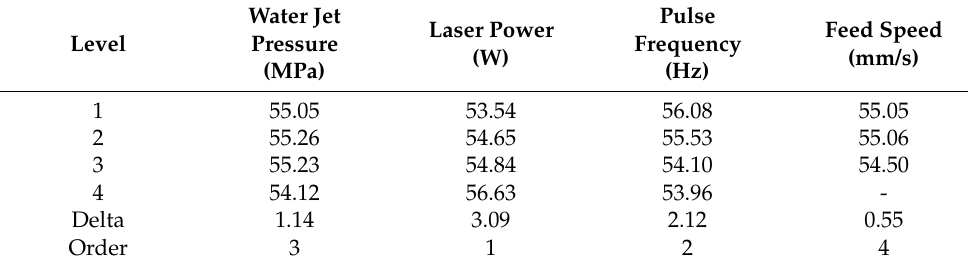
Table 5. S/N response